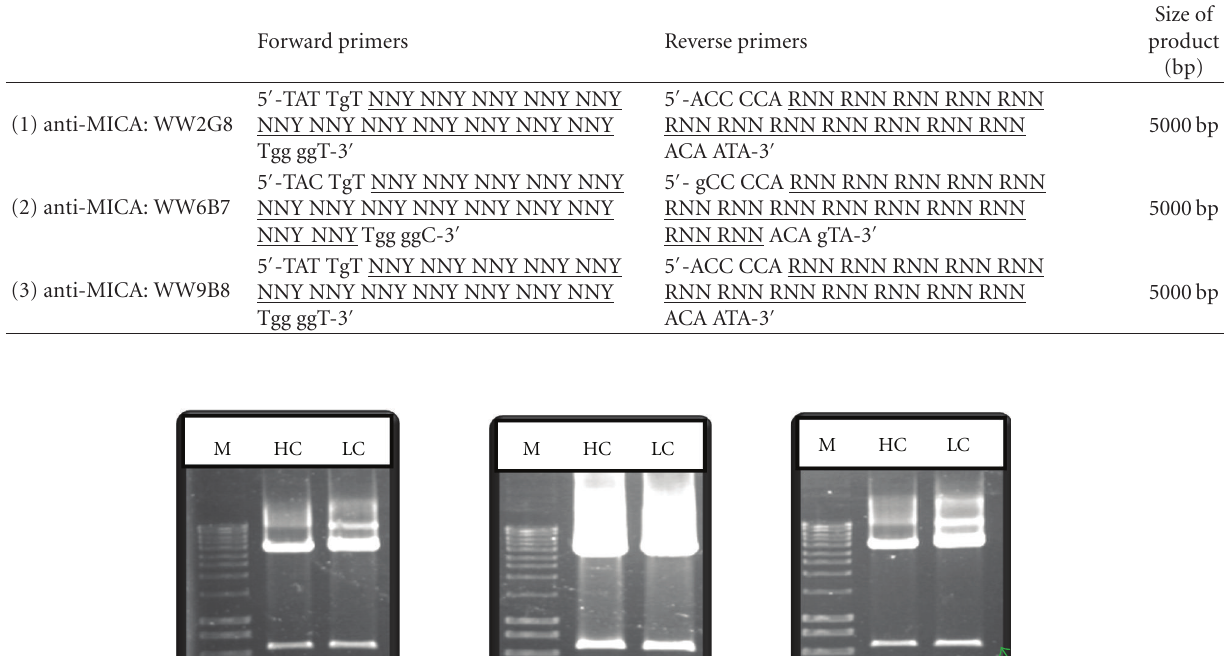
Table 1: Primers for PCR-random mutation of HCDR3 region of anti-MICA antibodies.